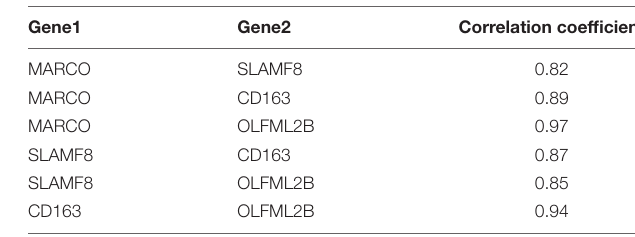
TABLE 3 | The correlation between the genes.